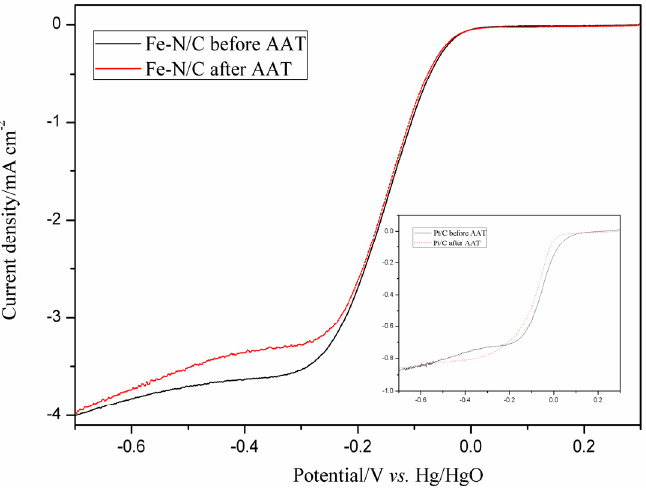
Figure 3. Oxygen reduction reaction (ORR) polarization curves for Fe–N/C and Pt/C (inset) before and after the accelerated aging test (AAT) in 0.1 M KOH solution at 1600 rpm.